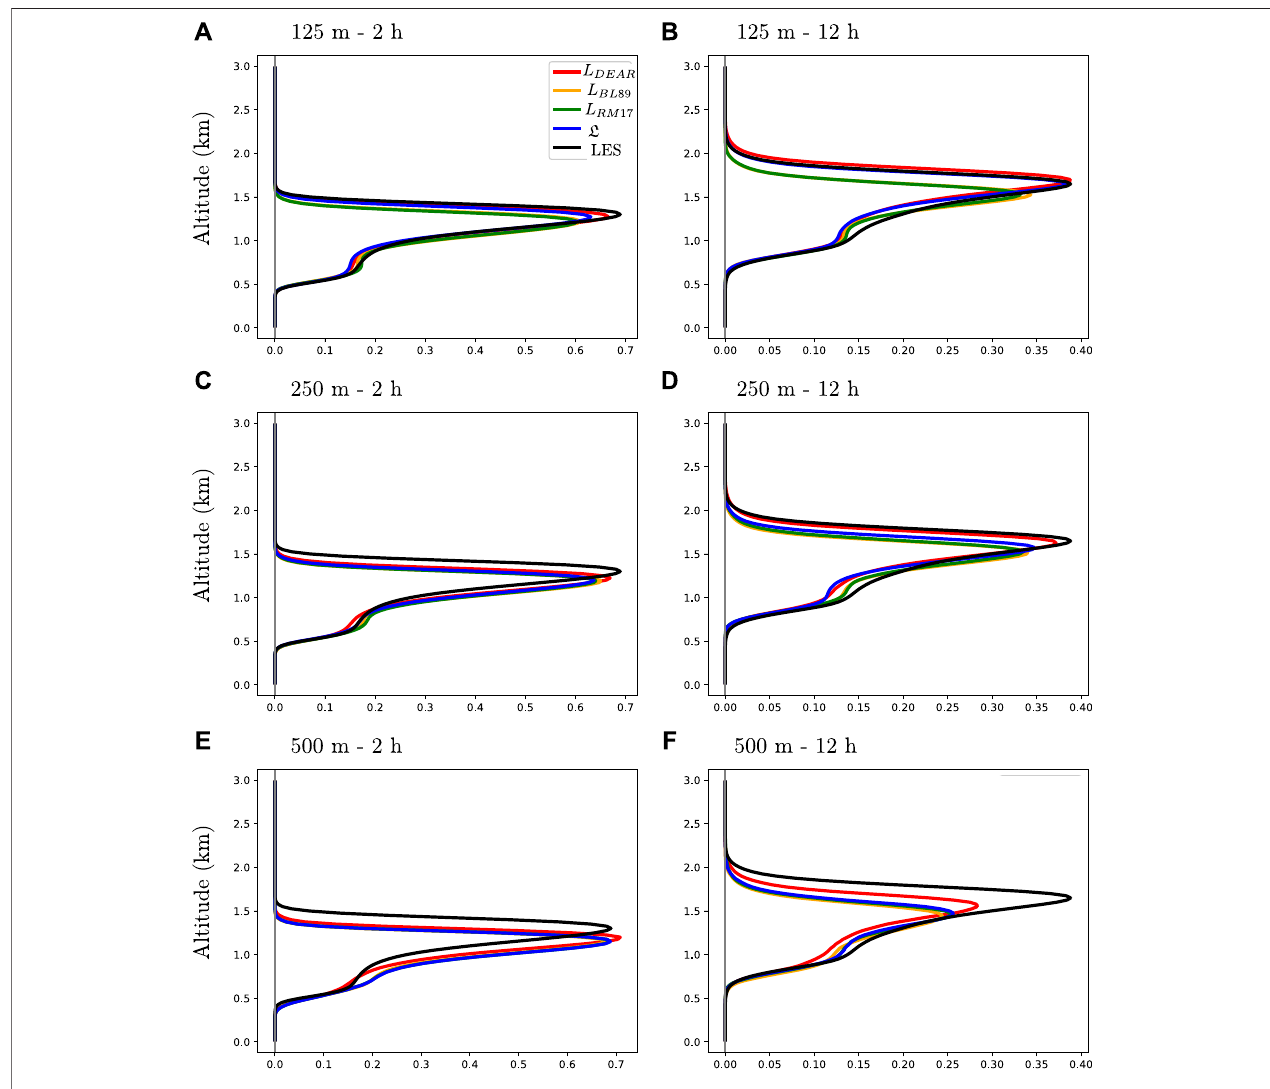
FIGURE10 | Vertical pro fi les ofmean cloud fraction forCONSTRAIN simulationsat 2 h (left column)and 12 h(rightcolumn) at the grid spacing of125 m (top row), 250 m (middle), 500 m (bottom row) with DEAR (in red), BL89 (in orange), RM17 (in green), L mixing length (in blue) and the reference LES coarse-graining (black).